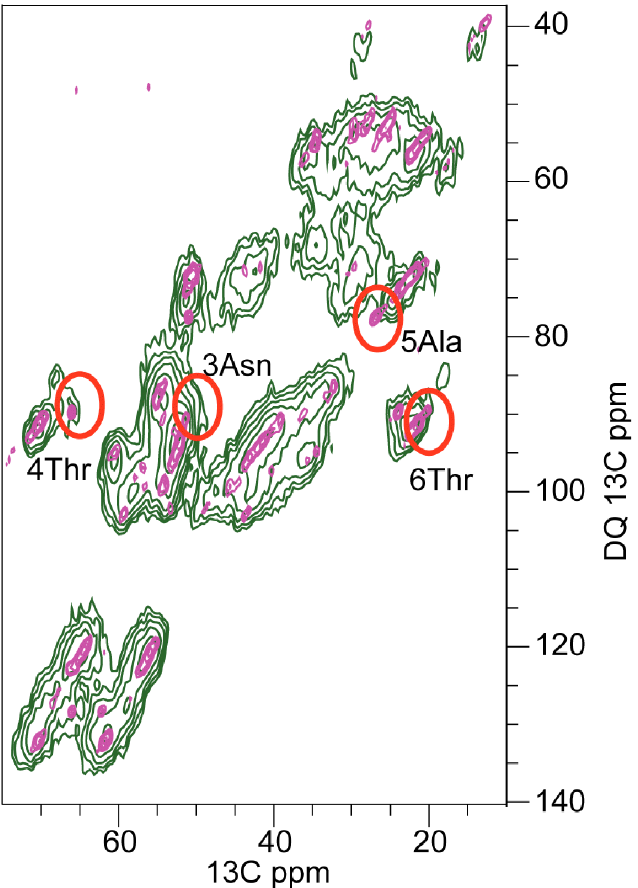
with Dynamic-Nuclear Polarization (DNP) at 100 Kelvin nominal sample temperature and SPC5_2 recoupling at 8 kHz MAS. The purple spectrum was acquired with conventional solid-state NMR technique at 0°C nominal sample temperature with SPC5_3 recoupling at 11 kHz MAS. In the DNP experiment, the sample was frozen out and it is obvious, that the N-terminal C α -C β cross-peak are broadened due to impeded molecular